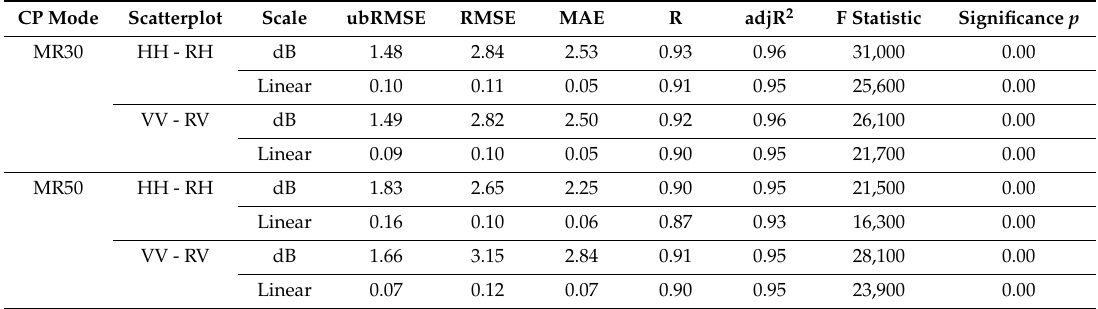
Table 1. Comparison statistics between simulated RADARSAT Constellation Mission (RCM) Compact Polarimetry (CP) intensities and RADARSAT-2